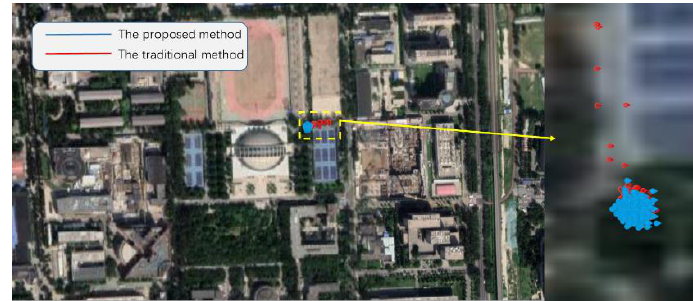
Table 1. Root Mean Square of position error under vehicle stationary condition.